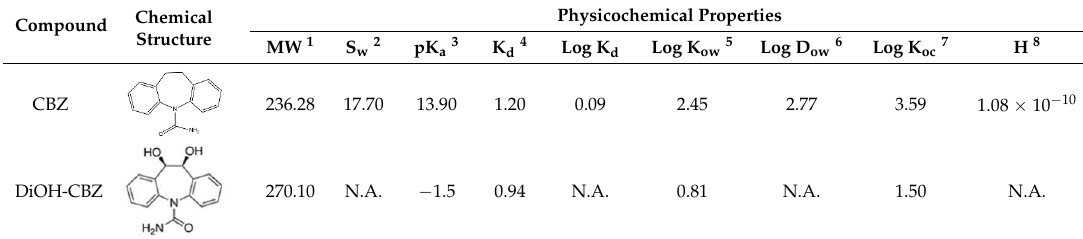
Figure 1. The contribution of different degradation pathways to CBZ degradation in constructed wetlands (CWs). Table 2. Overview of the physicochemical properties of CBZ and frequently investigated CBZ metabolites in CWs.